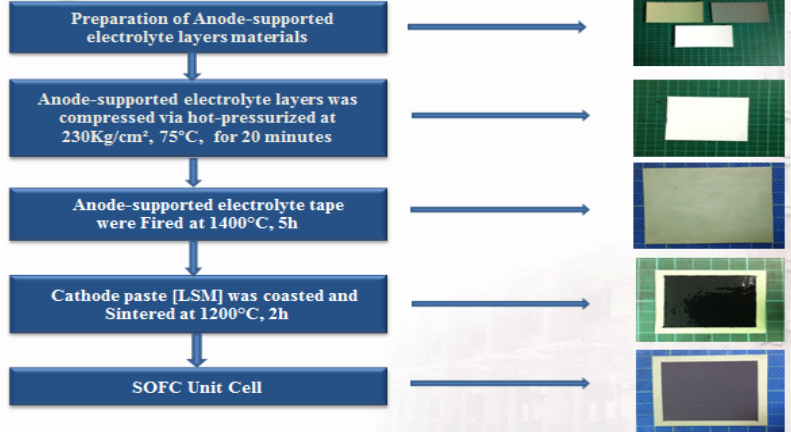
Figure 1. Diagram of the manufacturing process for a solid oxide fuel cell (SOFC).